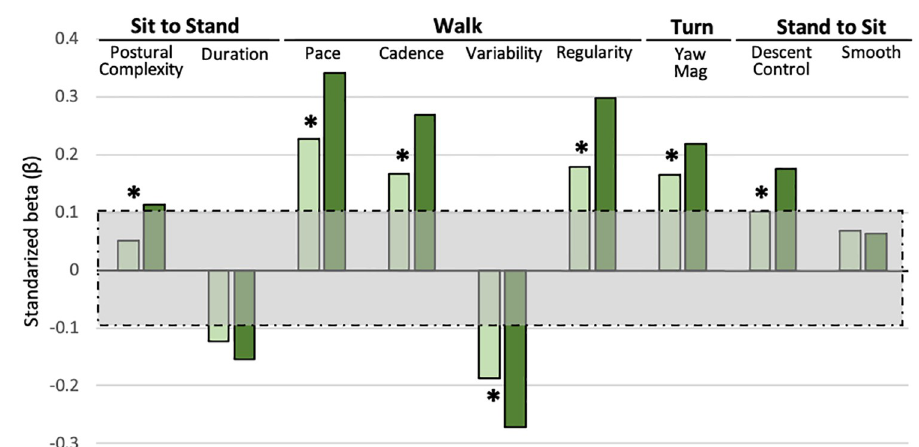
Fig 2. Quantitative TUG vs. global cognition. TUG subtasks vs. the global cognition composite, adjusted for age, sex, race, and education. Nine mobility scores quantifying the four TUG subtasks were calculated for normal (light green) and dual-task (dark green) TUG. A standardized beta ( β ) beyond the [-0.10, 0.10] shaded box corresponds to p < .005, while a β beyond [-0.133, 0.133] corresponds to p < .0001. � indicates associations that significantly differ across